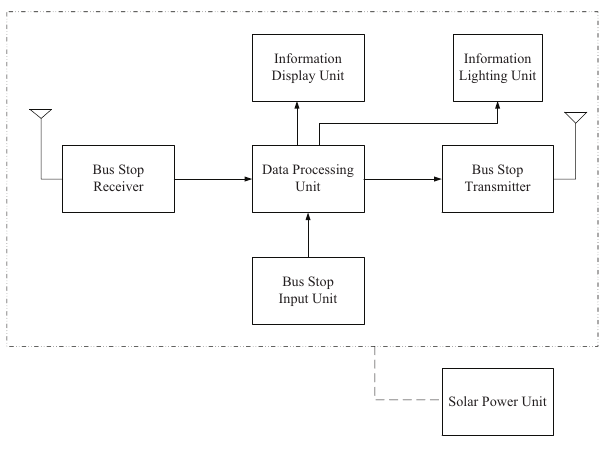
Figure 5. The major components of an interactive bus stop. Notice that a triangle pointing down represents an antenna.